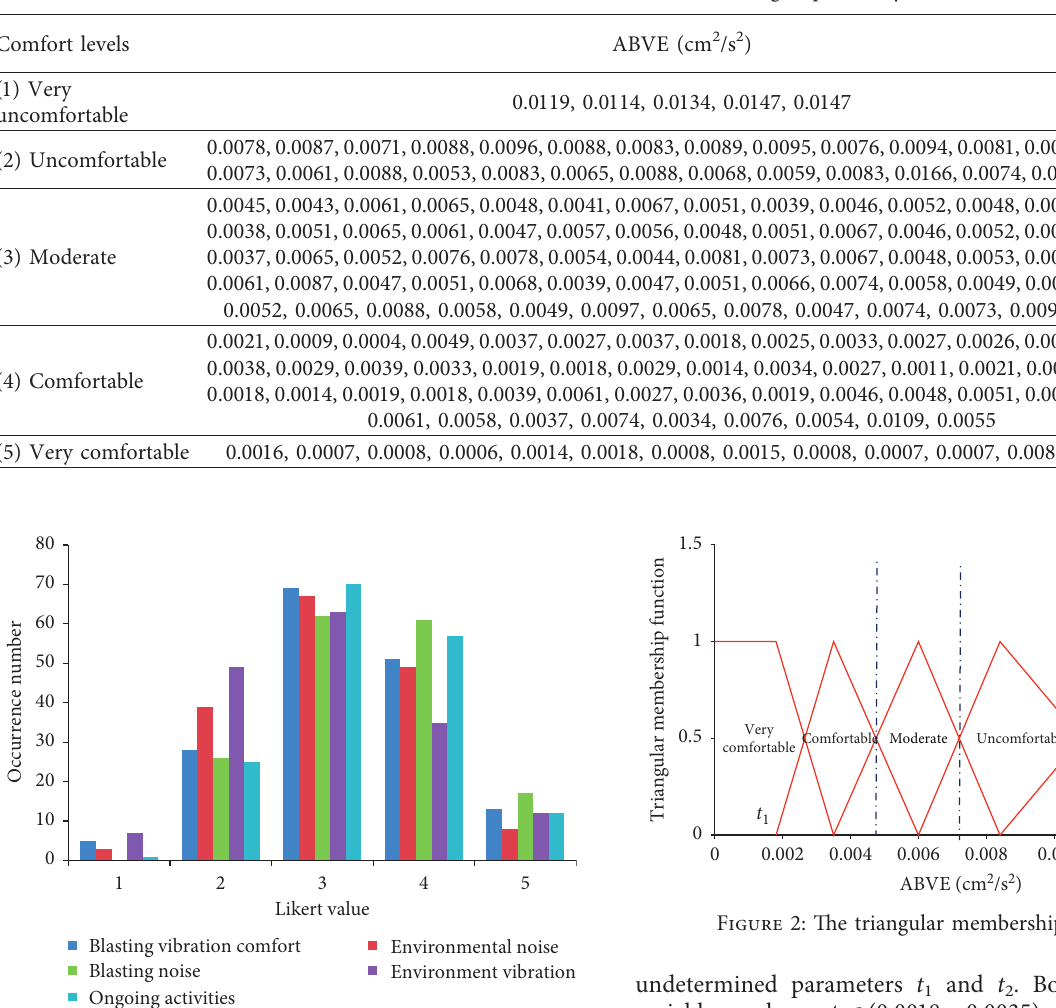
Table 3: The distribution of ABVE index based on 166 groups’ survey results.